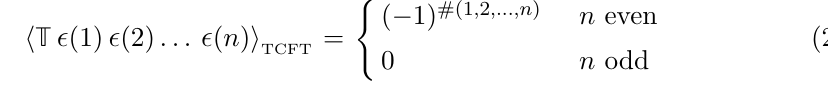
and x (cid:6) of the respective 1 2 x (cid:6) . We can abbreviate (cid:6)